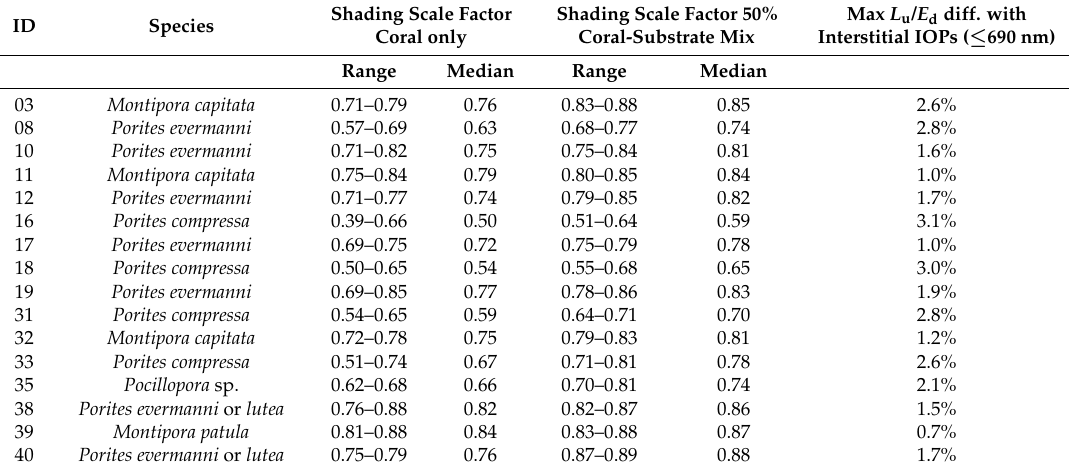
Table 3. Shading factors for coral area only and coral with surrounding substrate in 50% mix. Final column shows the maximum difference in the reflectance of any band up to 690 nm, when interstitial attenuation and scattering is included in the canopy